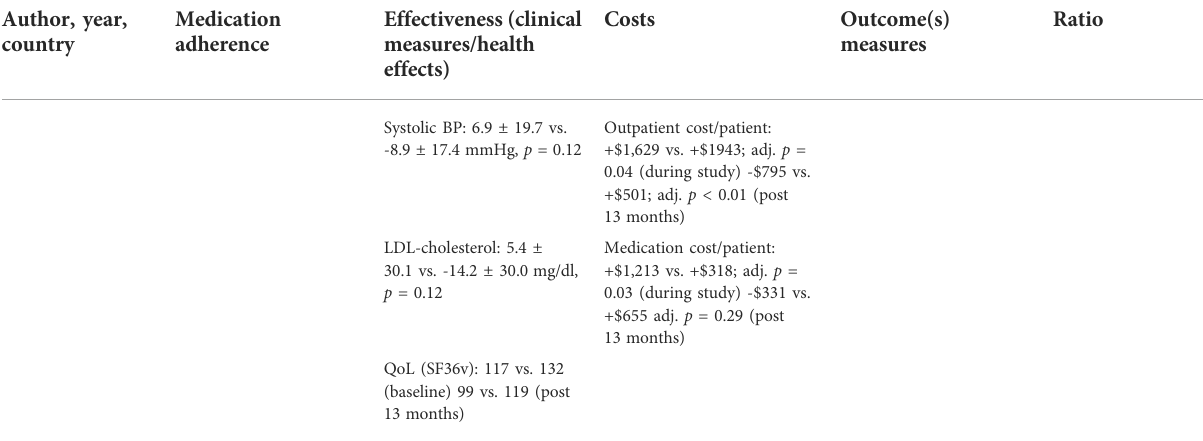
TABLE 2 ( Continued ) Effectiveness and economic outcomes of a systematic review of the cost-effectiveness of different types of educational interventions in type II diabetes mellitus. Author, year,